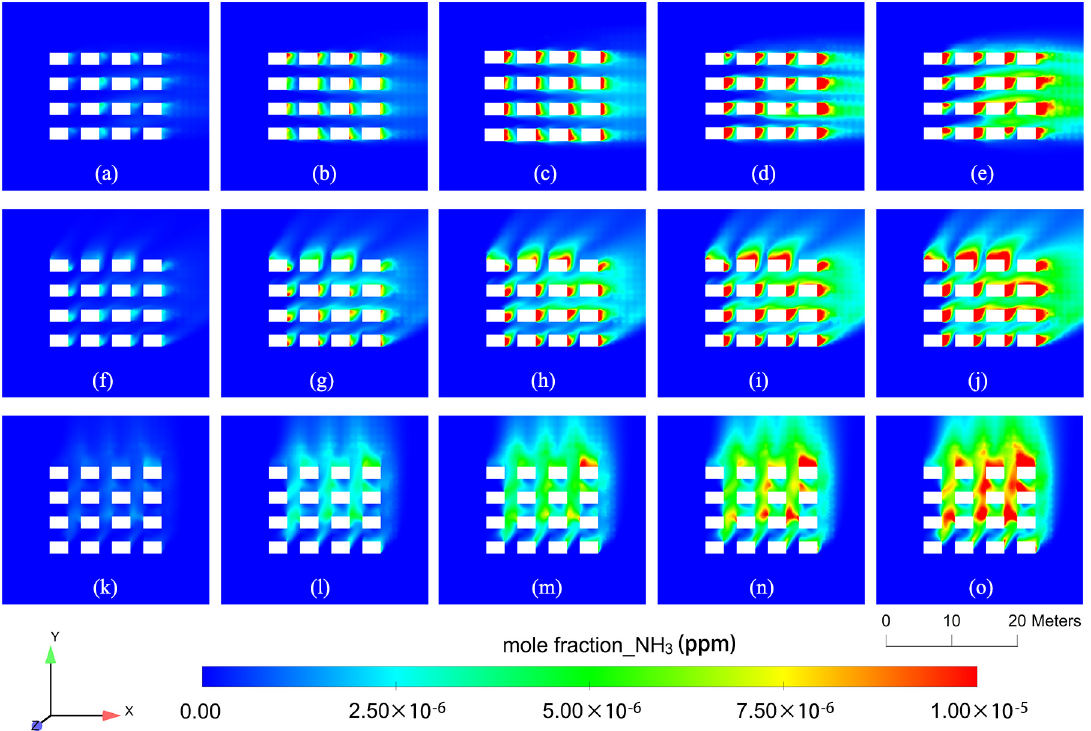
Figure 5. Ammonia mole fraction at 1.5 m above the ground in scenarios with 2 m intervals, in which the wind direction and outlet emission intensity are: ( a ) 0° and 10 ppm; ( b ) 0° and 30 ppm; ( c ) 0° the wind direction and outlet emission intensity are: ( a ) 0 ◦ and 10 ppm; ( b ) 0 ◦ and 30 ppm; ( c ) 0 ◦ and and 50 ppm; ( d ) 0° and 70 ppm; ( e ) 0° and 90 ppm; ( f ) 45° and 10 ppm; ( g ) 45° and 30 ppm; ( h ) 45° 50 ppm; ( d ) 0 ◦ and 70 ppm; ( e ) 0 ◦ and 90 ppm; ( f ) 45 ◦ and 10 ppm; ( g ) 45 ◦ and 30 ppm; ( h ) 45 ◦ and and 50 ppm; ( i ) 45° and 70 ppm; ( j ) 45° and 90 ppm; ( k ) 90° and 10 ppm; ( l ) 90° and 30 ppm; ( m ) 90° 50 ppm; ( i ) 45 ◦ and 70 ppm; ( j ) 45 ◦ and 90 ppm; ( k ) 90 ◦ and 10 ppm; ( l ) 90 ◦ and 30 ppm; ( m ) 90 ◦ and and 50 ppm; ( n ) 90° and 70 ppm; ( o ) 90° and 90 ppm. 50 ppm; ( n ) 90 ◦ and 70 ppm; ( o ) 90 ◦ and 90